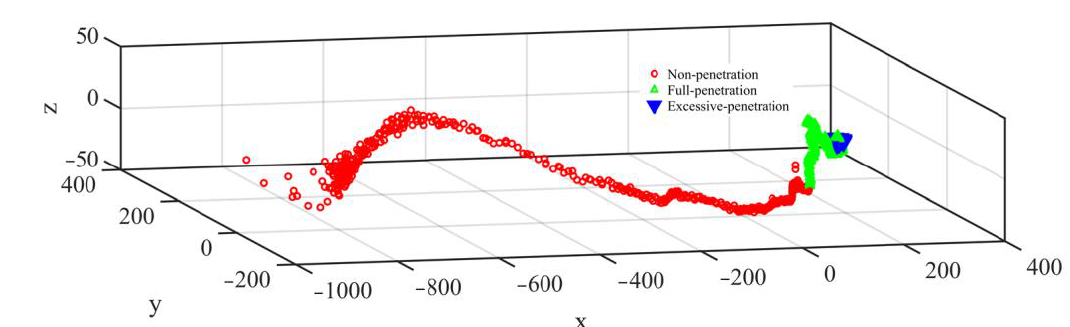
Figure 9. Display results of the linear temperature distribution features of the weldment surface after dimension reduction.